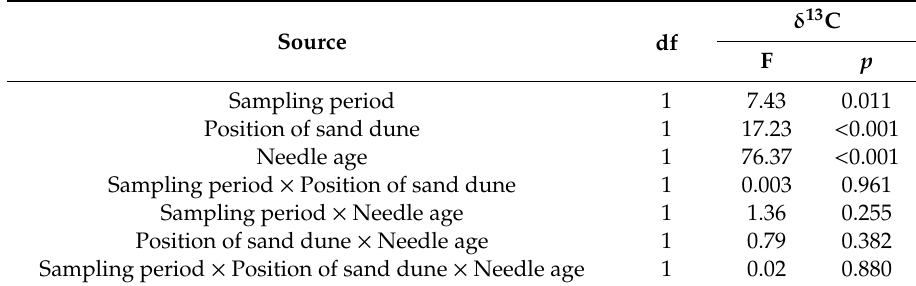
Table 3. Summary results of mixed model analyses in the needle δ 13 C by sampling period, the position of the sand dune and needle